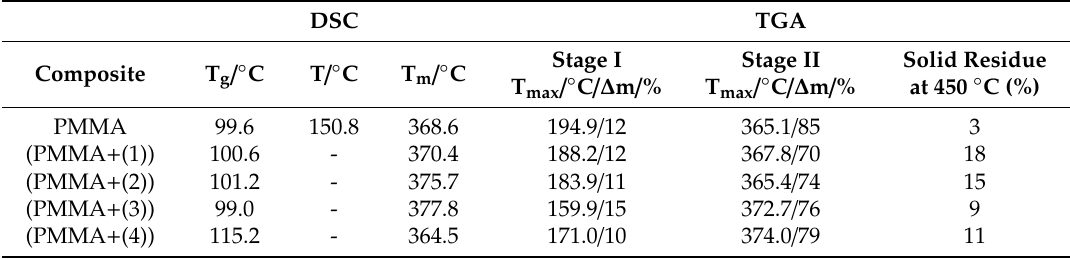
Table 4. Thermal parameters received from thermogravimetric analysis (TGA) and differential scanning calorimetry (DSC) of the poly(methyl methacrylate) (PMMA) and (PMMA + TOCs) composites (T g = glass transition temperature, T = evaporation temperature of an unreacted monomer, T m = melting temperature. T max = temperature in the thermal transition maximum, ∆ m = thermal transition weight loss).